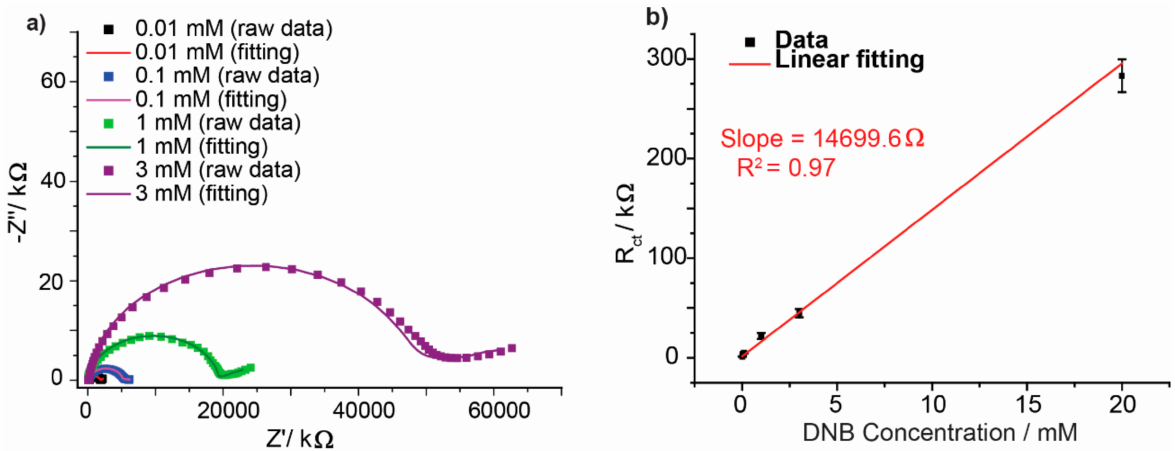
Figure 5. ( a ) Nyquist plot of the EIS for the polymeric film formed by reducing different concentra- tions of DNB in organic electrolyte, followed by EIS measurement in Ru (NH 3 ) 63+/2+ solution. Dots represent raw data and lines represent the equivalent Randles circuit fitting. ( b ) Calibration curve built from measuring the charge transfer resistance (R ct ) obtained from different DNB concentrations in the range of 0.01 mM to 20 mM and fitted with a linear regression of R 2 =